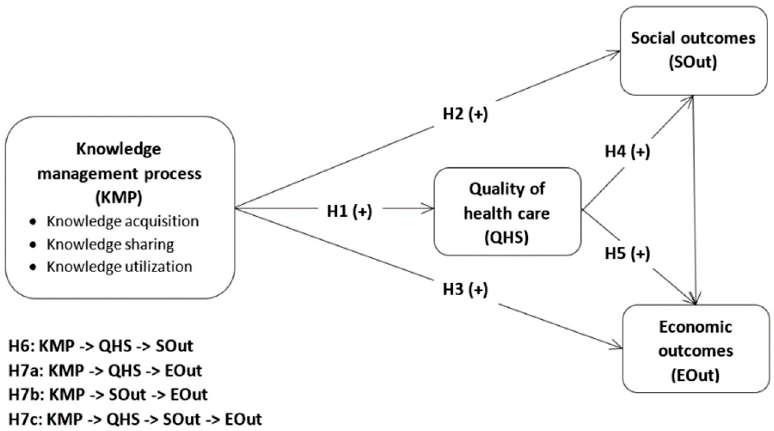
Figure 1. Conceptual model and hypotheses.